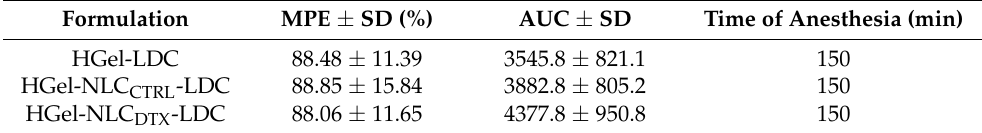
Table 3. Tail-flick test in mice. Percent Maximum Possible Effect (MPE), Area under the curve (AUC) and time of anesthesia for the hydrogel lidocaine formulations (HGel-LDC), hydrogel plus NLC